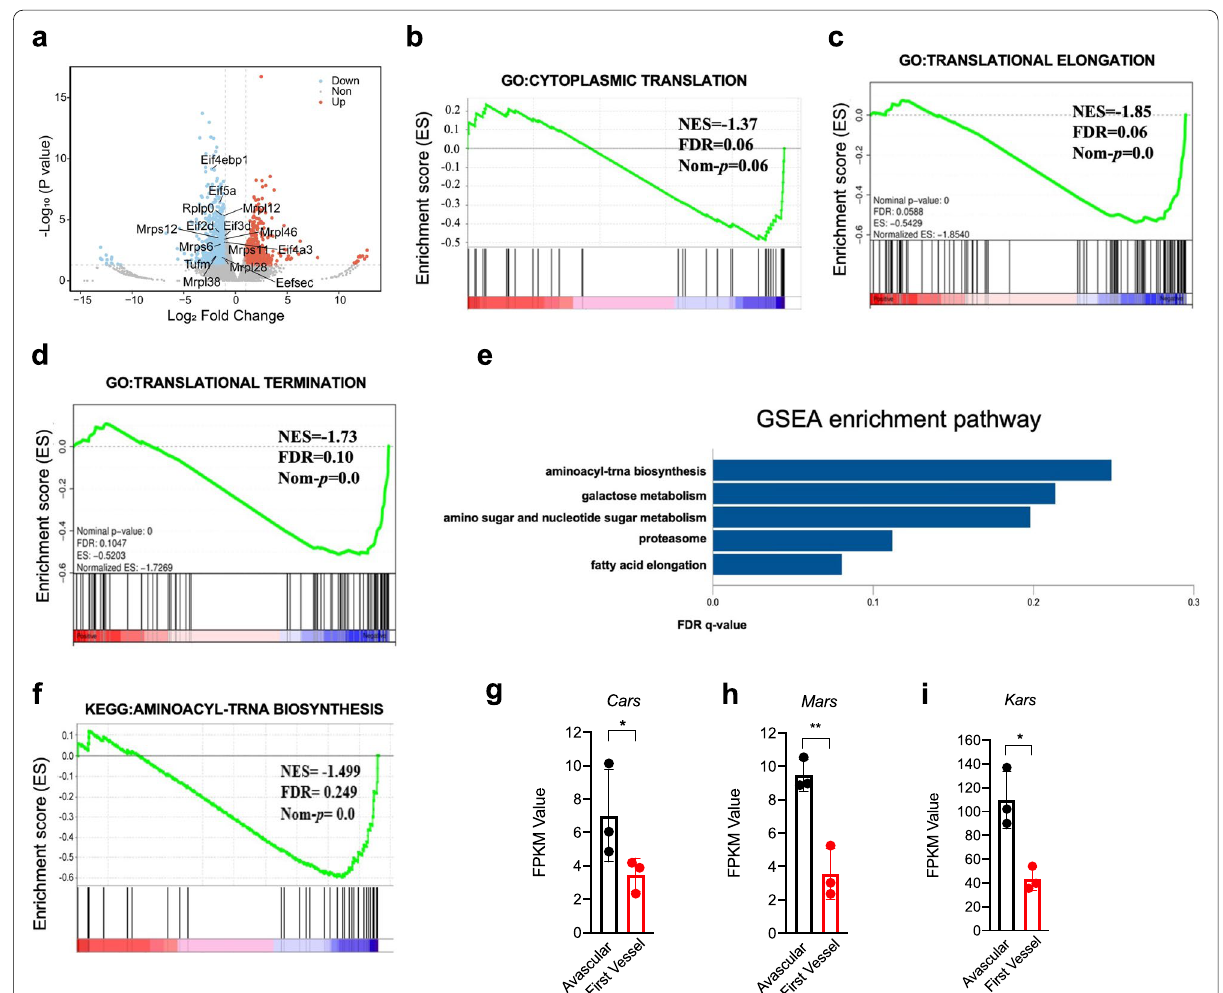
Fig. 5 Inhibition of protein translation occurred during the angiogenic switch. a The volcano plot of the gene expression change of the dissected transplant microtumors transcriptome during the angiogenic switch ( n 3). b - d The GSEA analysis of transcriptome for the cytoplasmic translation, = translational elongation and translational termination gene sets ( n 3). e The GSEA analysis of transcriptome for the significantly changed pathways = during the angiogenic switch ( n 3). f The GSEA analysis of transcriptome for the aminoacyl-trans biosynthesis pathway during the angiogenic = switch ( n 3). g - i The change of FPKM of RNAseq data for some aminoacyl-tRNA synthetases of the aminoacyl-trans biosynthesis during the = angiogenic switch. Unpaired t-test, * P < 0.05, ** P < 0.01 ( n =